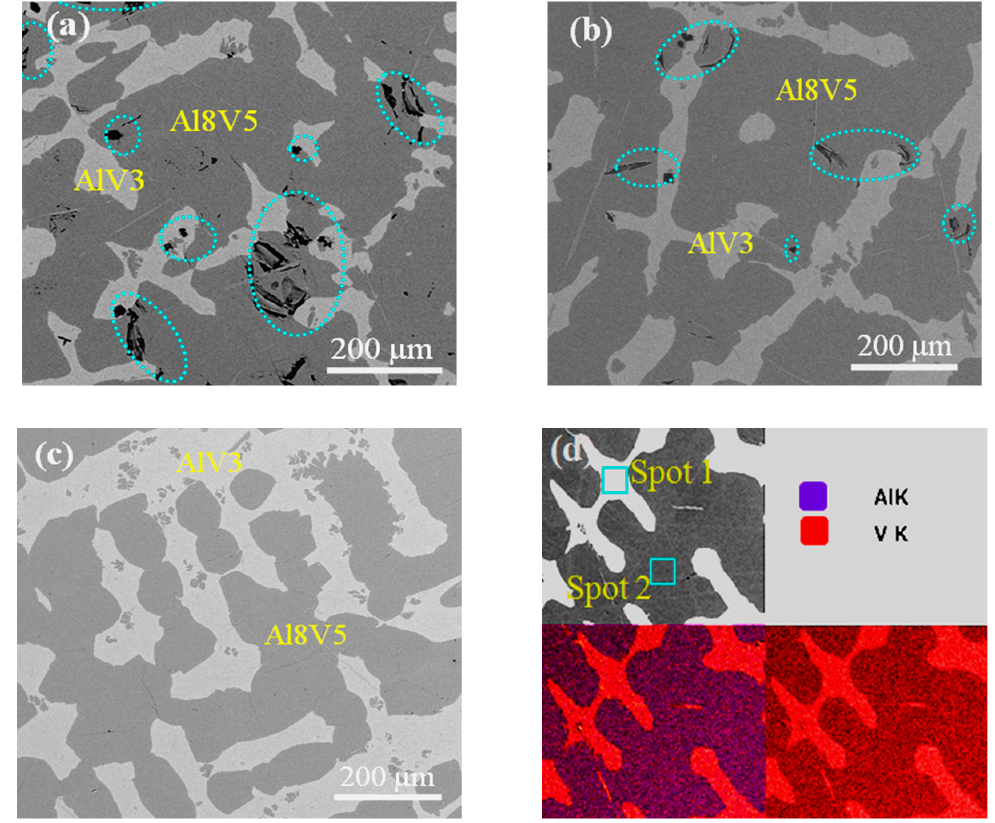
Figure 9. SEM micrographs of AlV55 alloy by di ff erent heating time ( a ): heating time = 3 min; ( b ): heating time = 5 min; ( c ): heating time = 7 min; ( d ): heating time = 9 min; and ( d ) the distribution of elements in the